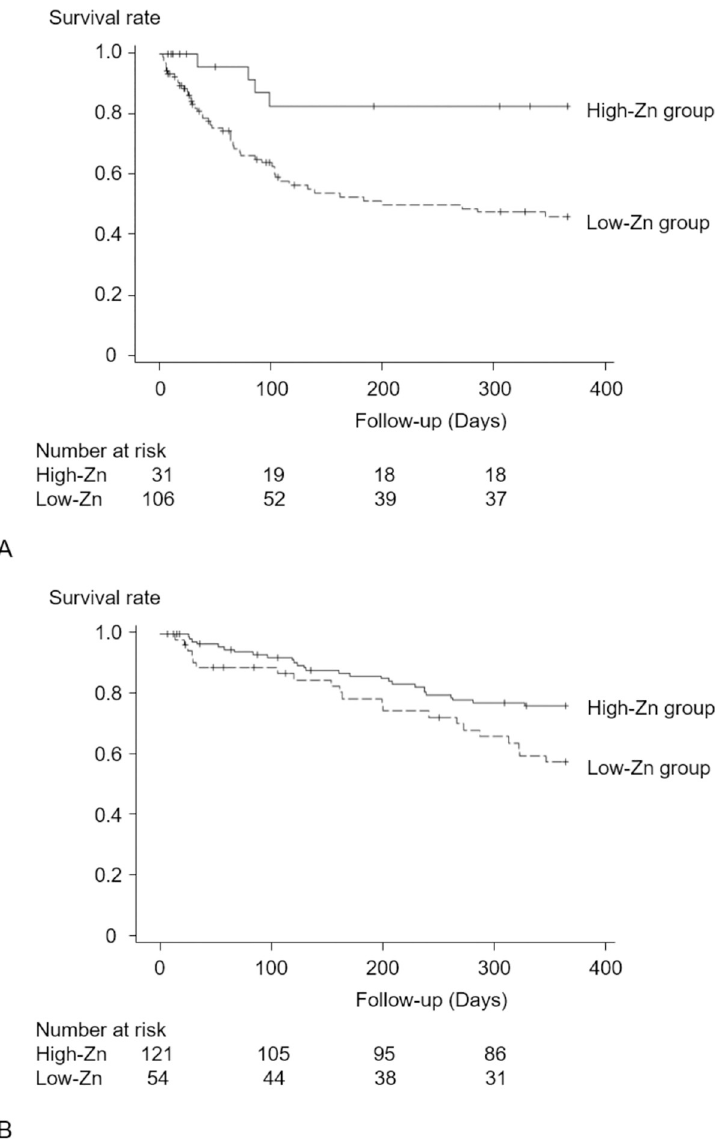
Fig 5. Survival rates in the subgroups classified by serum albumin levels. Kaplan-Meier curves for the primary outcome over 1 year. (A) Patients with low serum albumin levels ( < 3.2 g/dl). (B) Patients with high serum albumin levels ( � 3.2 g/dl). Survival rates were compared between the two groups by the log-rank test. The survival rate was lower in the low-Zn group than in the high-Zn group (A, log-rank test, p = 0.003; B, log-rank test, p = 0.020). https://doi.org/10.1371/journal.pone.0251554.g005 Table 4. Association of Zn levels with the primary outcome in subgroups according to serum albumin levels.